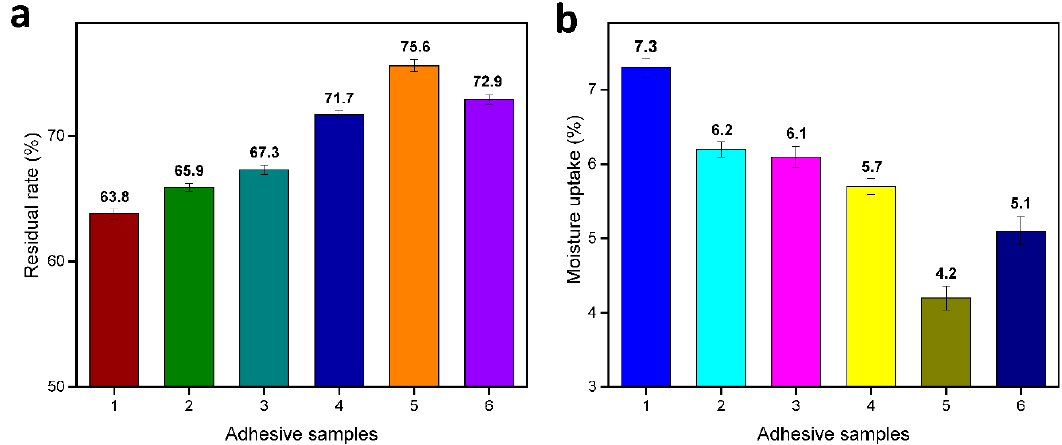
Figure 5. ( a ) Residual rate and ( b ) moisture uptake of the cured adhesives. 1: SM, 2: SM / TGIC, 3: SM / TGIC / DAS-5, 4: SM / TGIC / HD-2.5, 5: SM / TGIC / HD-5, and 6: SM / TGIC / HD-7.5.